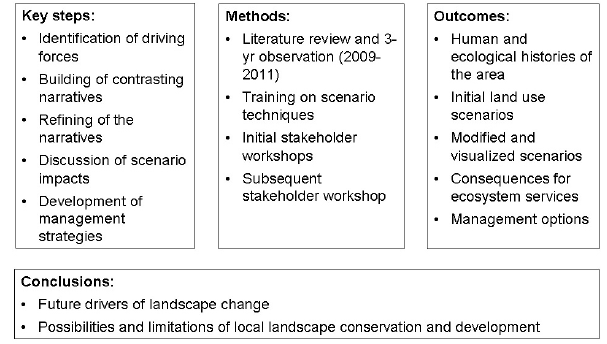
Fig. 5 . Key steps, methods, outcomes, and conclusions of the scenario